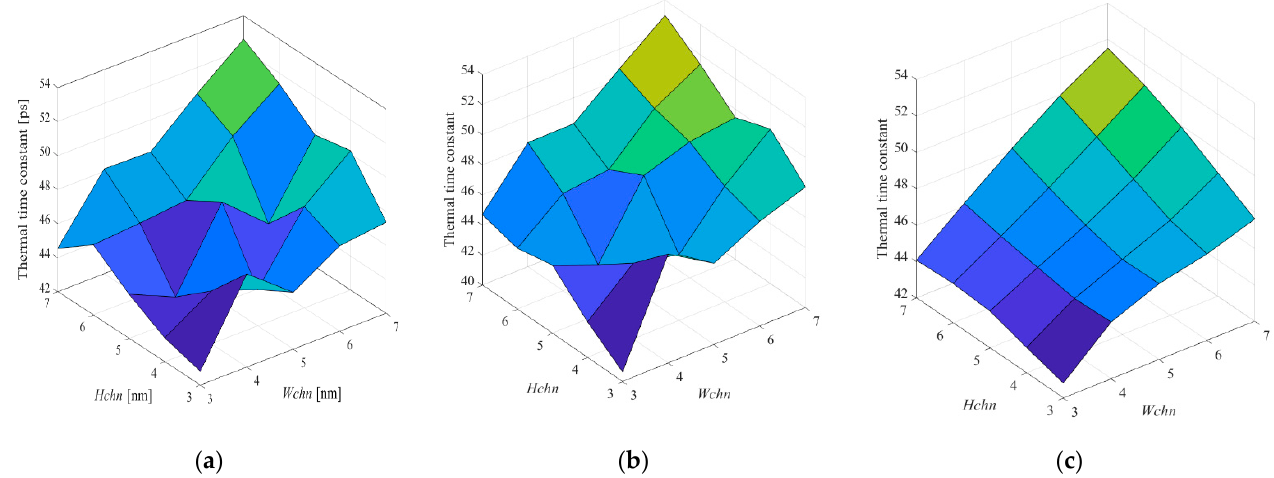
Figure 6. Comparison of responses of the ( a ) TCAD surface, ( b ) intentionally over-trained neural network surface, and ( c ) our neural network surface .